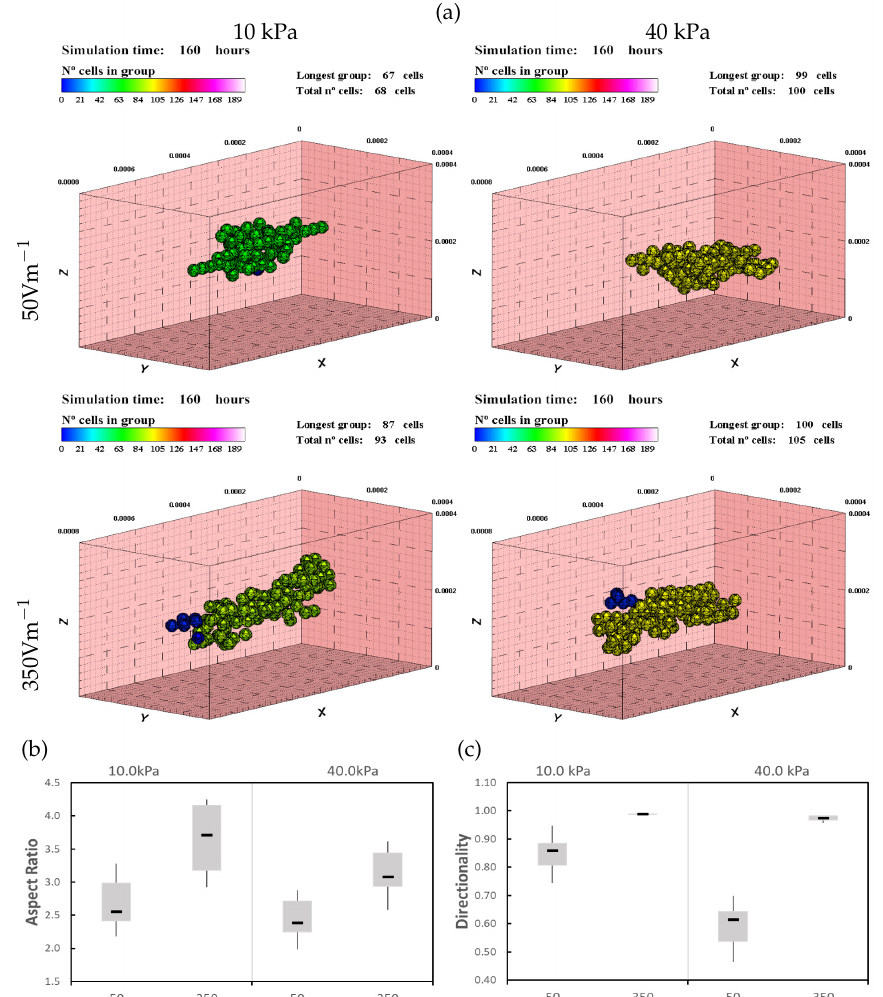
Figure 10. CMs in 10 and 40 kPa ECMs, under an alternating electric field of 50 and 350 Vm − 1 , after 160 h of simulation (see also Supplementary Materials video 3). ( a ) Higher tendency to form a group in the longitudinal direction is observed. Cells remain close to the center of the ECM where the cells maturate faster and the proliferation rate increases. Larger and better-oriented groups are formed by applying an alternating electric field, with better results for AR ( b ) and directionality ( c